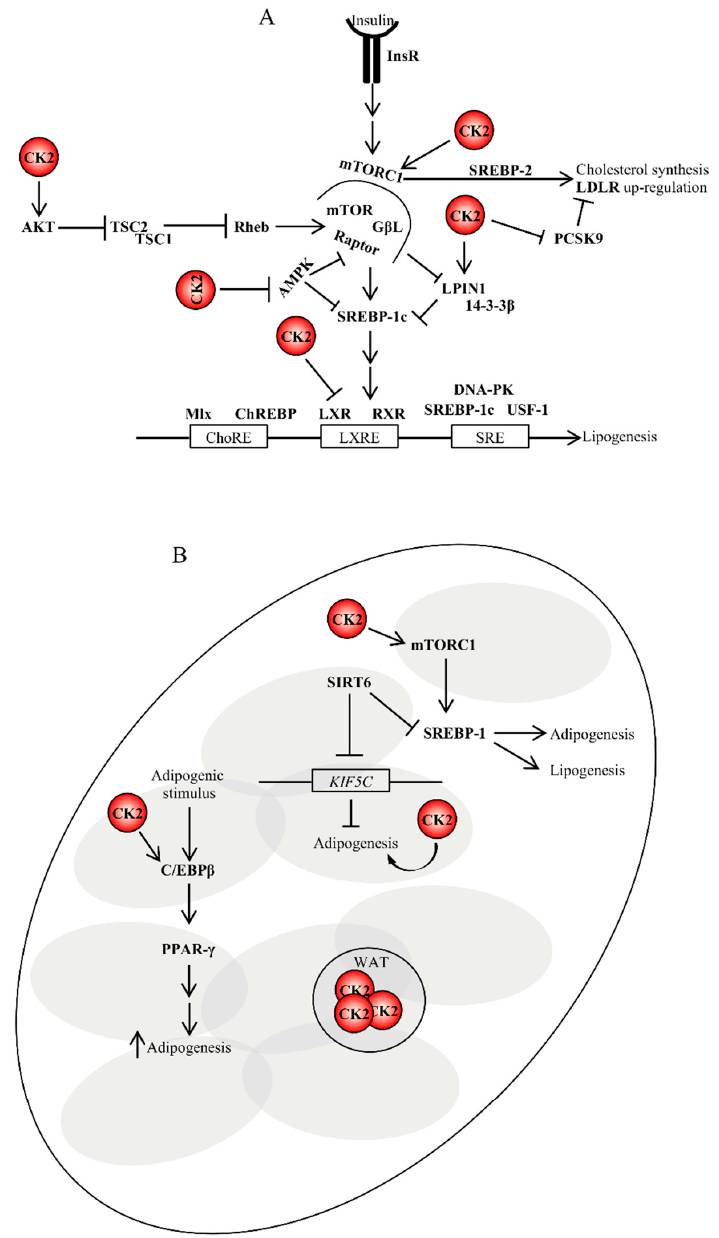
Figure 3. Role of CK2 in lipogenesis and adipogenesis. ( A ) CK2 controls lipogenesis at the translational levels. Insulin binding to its receptor on target cells results in the activation of lipid biosynthesis, which is a multi-step process regulated by key lipogenic enzymes. Their expression is controlled, at the transcriptional level, by the sterol regulatory element-binding proteins (SREBPs). To date, it is not known whether CK2 can directly regulate their activity; however, it does indirectly. ( B ) CK2 is also involved in the stimulation of adipogenesis in several ways as depicted in the figure and discussed in the text. For instance, CK2 positively regulates mTORC1 activity. mTORC1 upregulation stimulates the expression of SREBP1 promoting lipogenesis and adipogenesis. SIRT6 is an important regulator of lipogenesis as well. It represses SREBP1 by blocking its expression and processing [193]. SIRT6 is required for adipogenesis in vivo and in vitro. During adipogenesis, SIRT6 regulates mitotic clonal expansion of pre-adipocytes by repressing the expression of KIF5C and enhancing CK2 activity. ChoRE, carbohydrate response element; DNA-PK, DNA-dependent protein kinase; G β L, G protein beta subunit like; InsR, insulin receptor; LXRE, liver X-receptor response element; Mlx, Max-like protein; RXR, retinoid X receptor; SRE, sterol regulatory element; WAT, white adipose